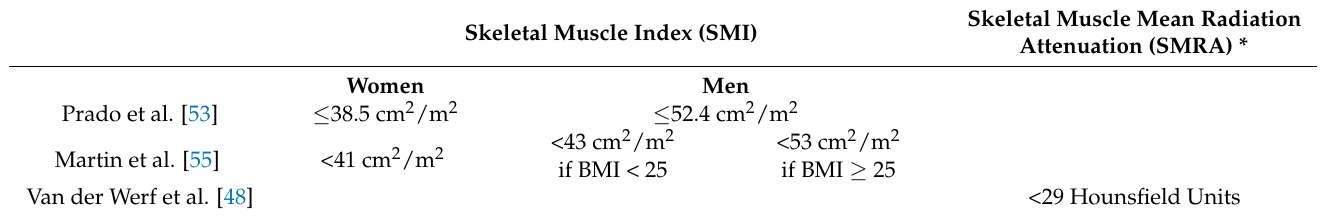
Table 2. Common cut-offs for sarcopenia definition based on CT-scan at the level of the third lumbar